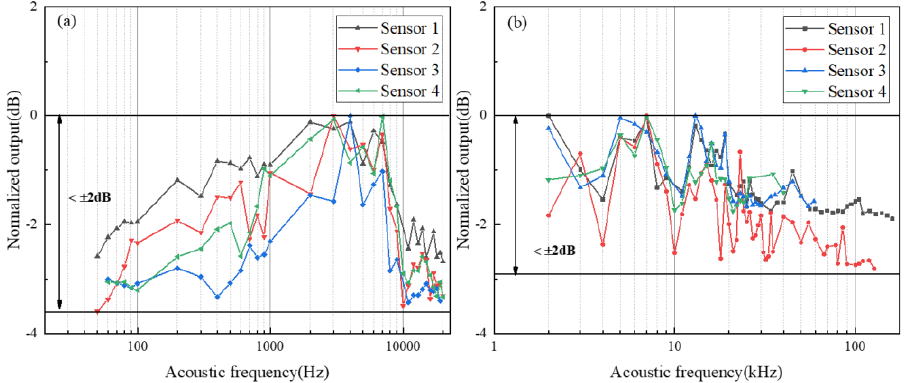
Figure 5. The frequency response and flatness of proposed sensors: ( a ) the frequency response with the loudspeaker; ( b ) the frequency response with the piezoelectric ceramics.